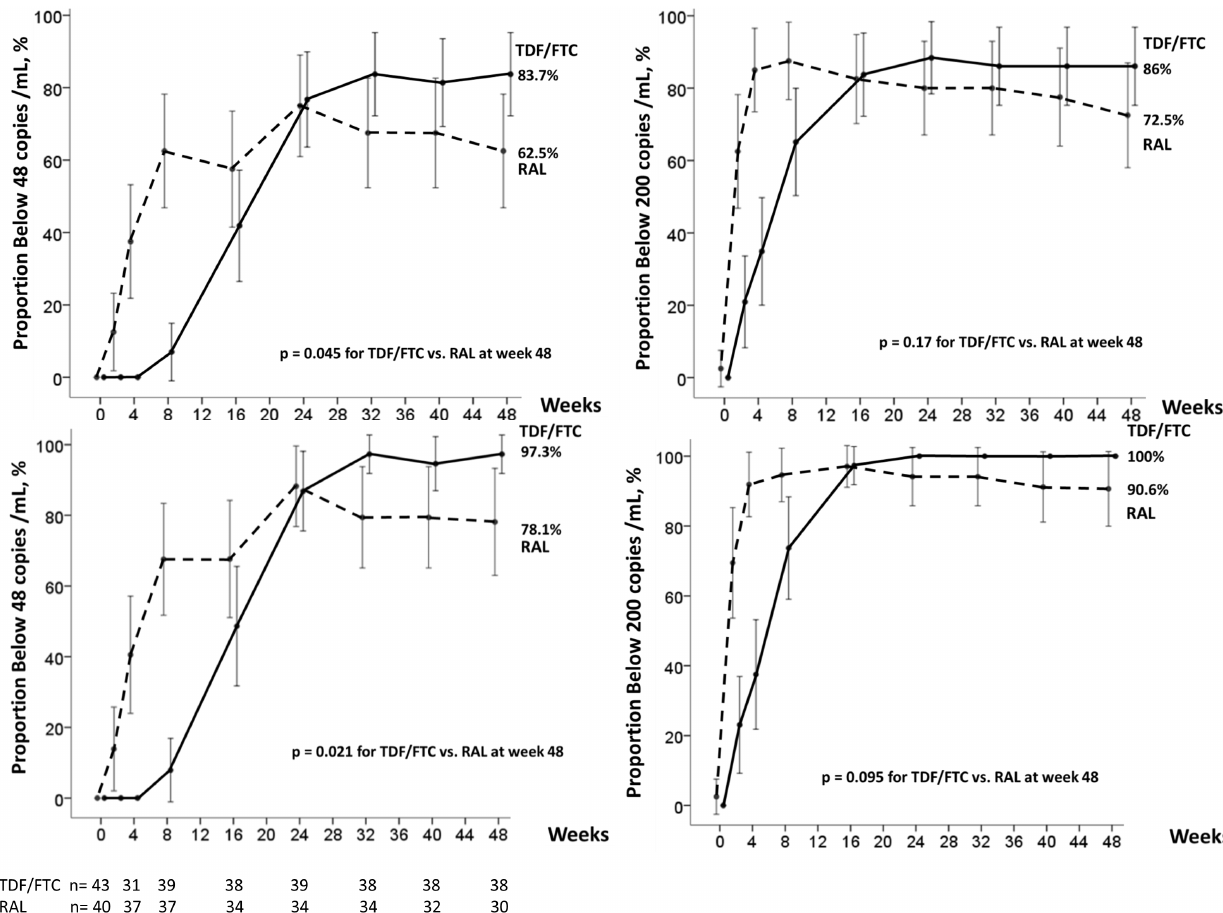
Figure 2. Proportion of subjects with plasma HIV-1 RNA , 48 copies/mL and , 200 copies/mL using the Intention-to-Treat Analysis (top) and the On-Treatment-Analysis (bottom, with number of patients